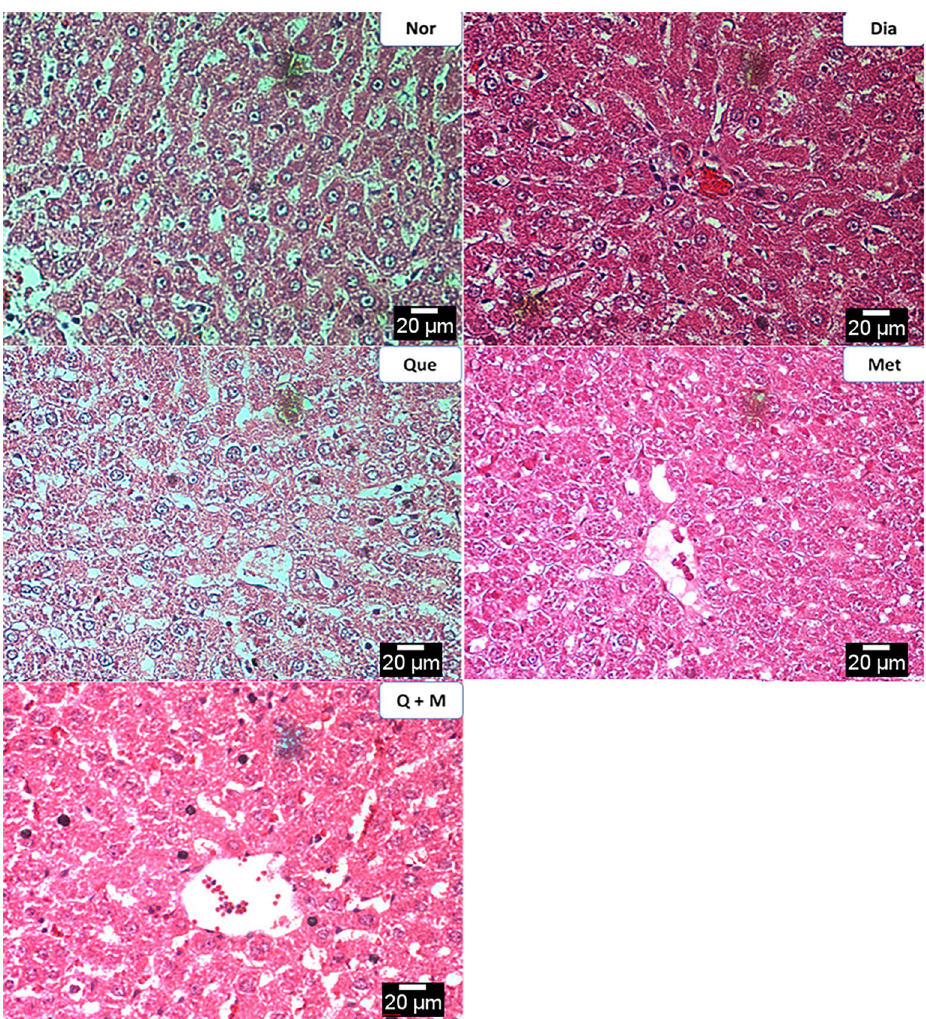
Figure 4. The effect of test compounds on liver histology in diabetic rats. Nor Normal, Dia Diabetic, Que Quercetin treated, Met Metformin treated, Q + M Quercetin + metformin treated diabetic